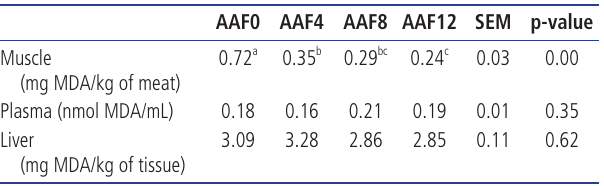
Table 5. Effect of increasing level of Alfalfa flavonoids extract (AAF) on oxidative status of the muscle, plasma and liver of growing rabbits (n =